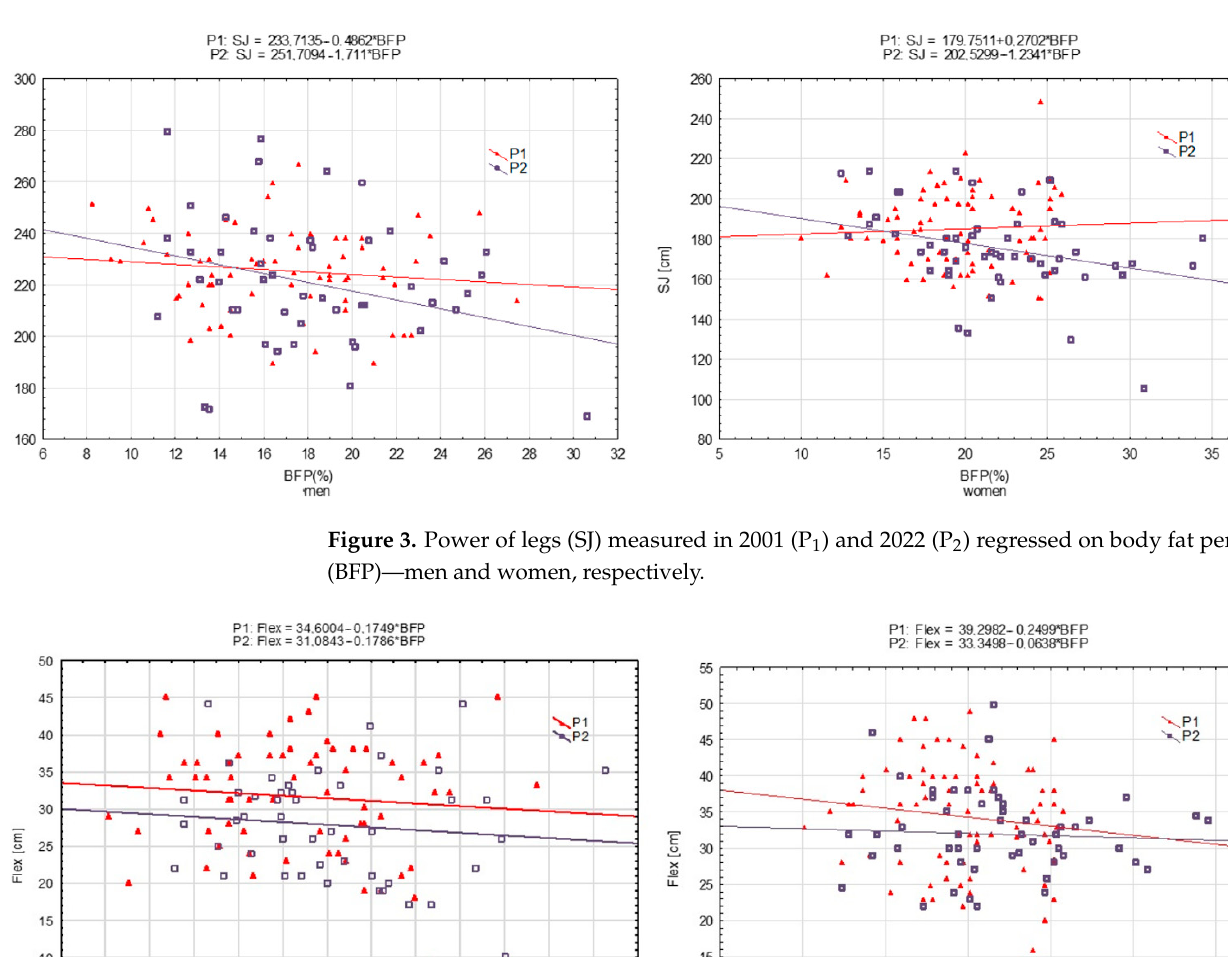
Figure 2. Abdomen strength (ABS) measured in 2001 (P 1 ) and 2022 (P 2 ) regressed on body fat percentage (BFP)—men and women, respectively.